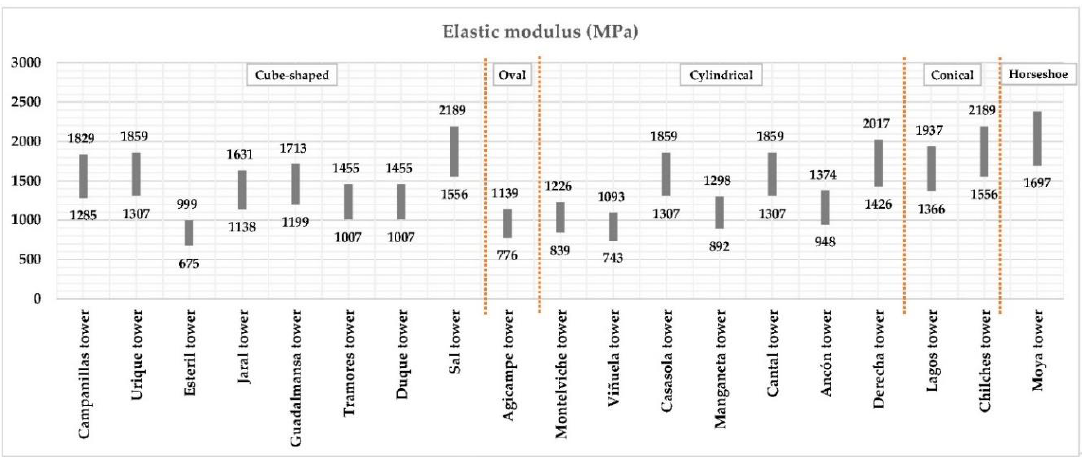
Figure 16. Elastic modulus of the masonry (E).